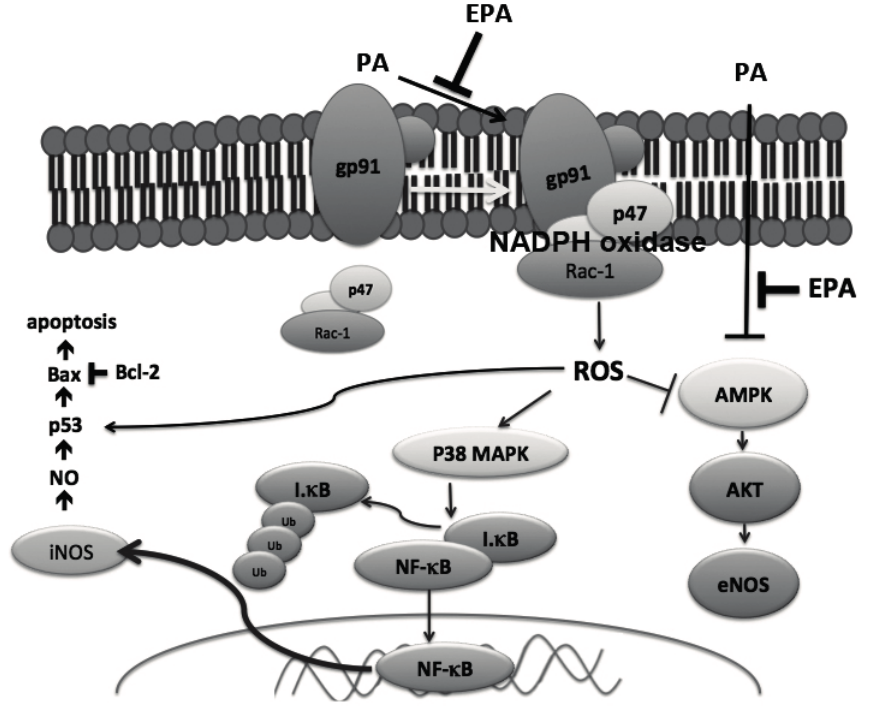
Figure 8. Proposed model of the protective effects of EPA against the PA-induced signaling pathway activation that leads to endothelial